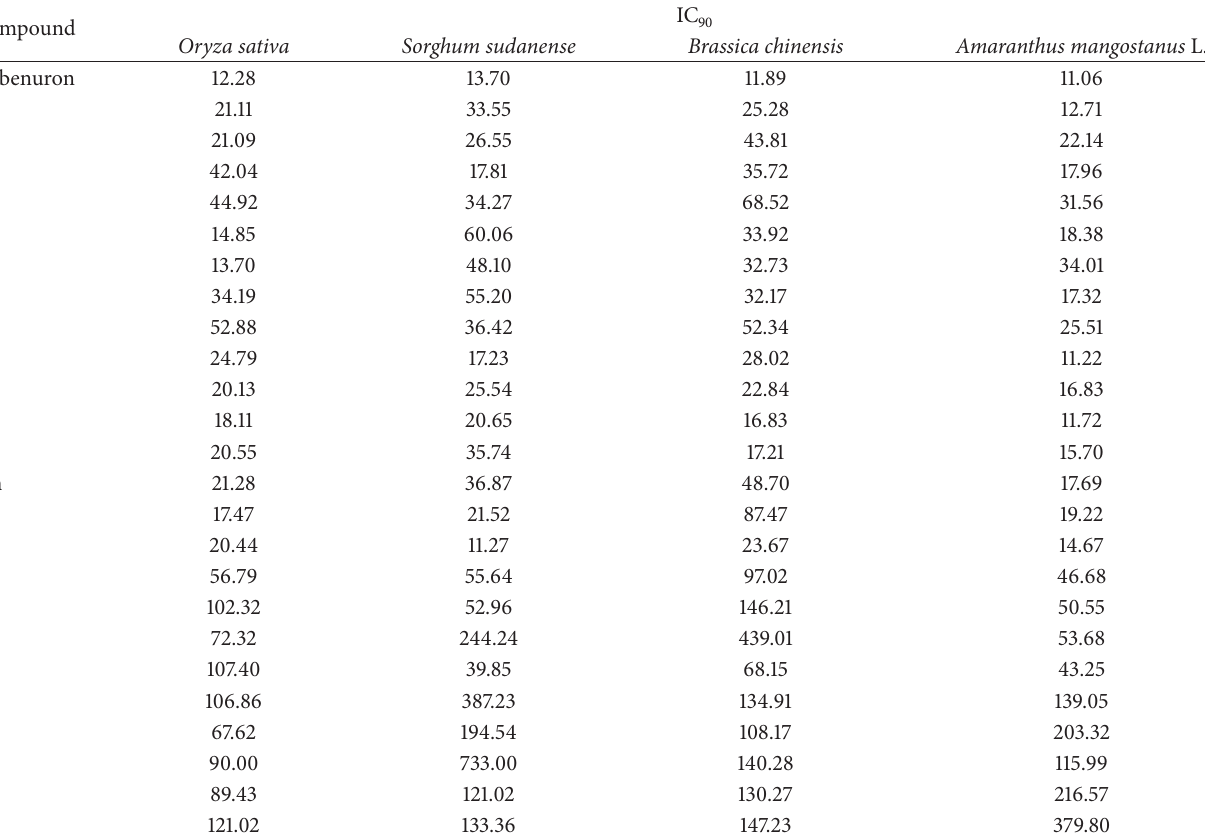
Table 2: Calculated IC 90 of compounds 5a – 5x .